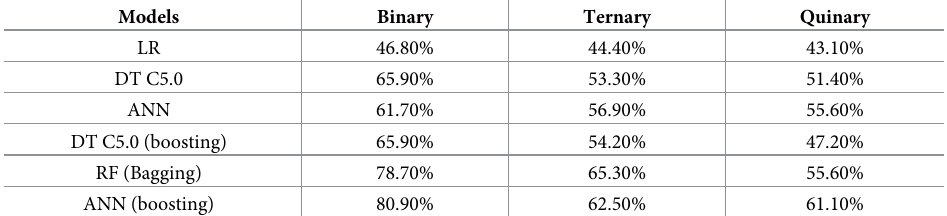
Table 13. Classification accuracy of the emotional quality of the two new spaces using the proposed binary, ter- nary, and quinary-class classification models.